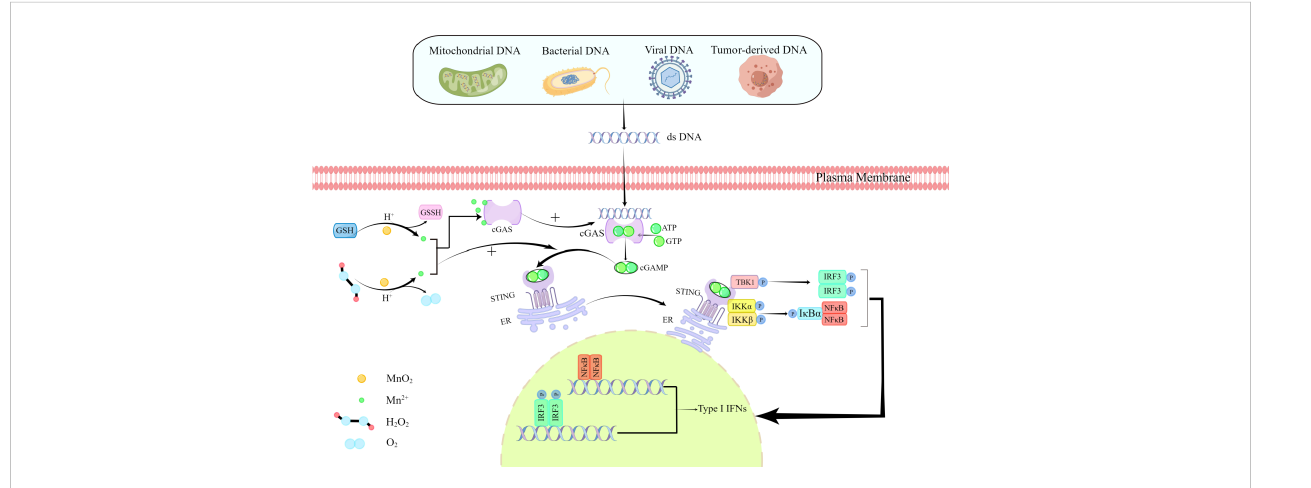
FIGURE 4 MnO 2 NPs activate cGAS-STING signaling pathway by releasing Mn 2+